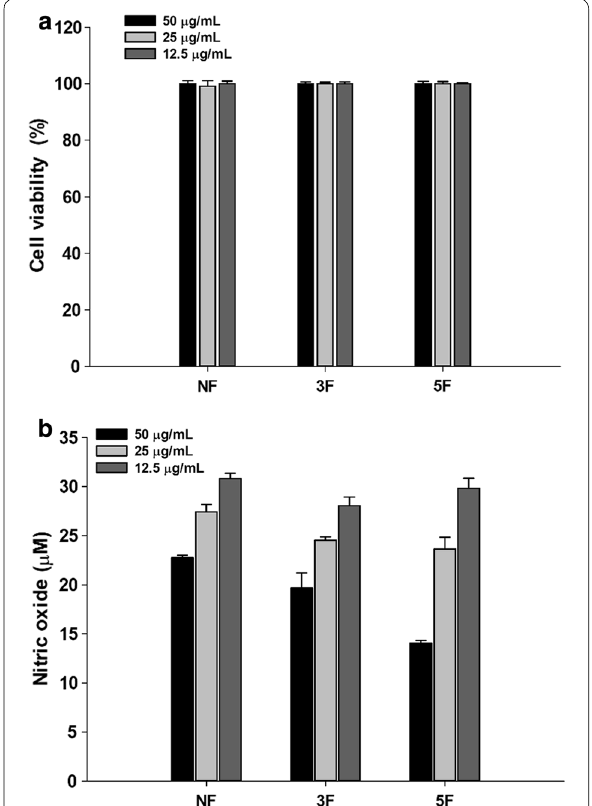
Fig. 2 Cell viability ( a ) and nitric oxide production ( b ) on RAW264.7 of quinoa and fermented quinoa extract. (NF;Non-fermented, 3F; 3 days, 5F; 5 days of fermented quinoa extracts) (NF vs 3F and 5F, **p <